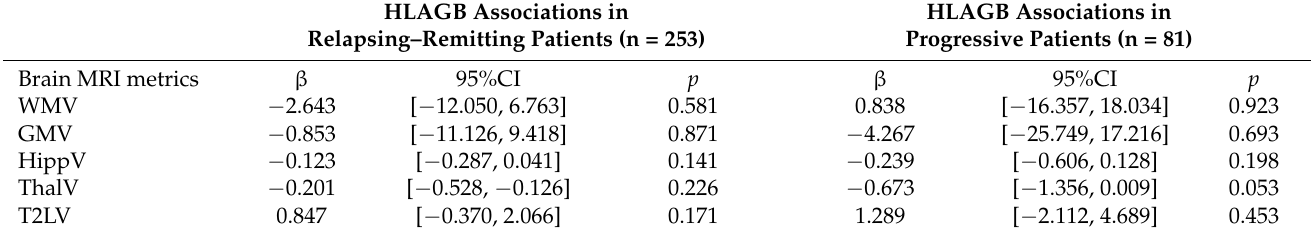
Table 3. HLAGB association statistics in relapsing–remitting and progressive patients (SPMS + PPMS). HLAGB Associations